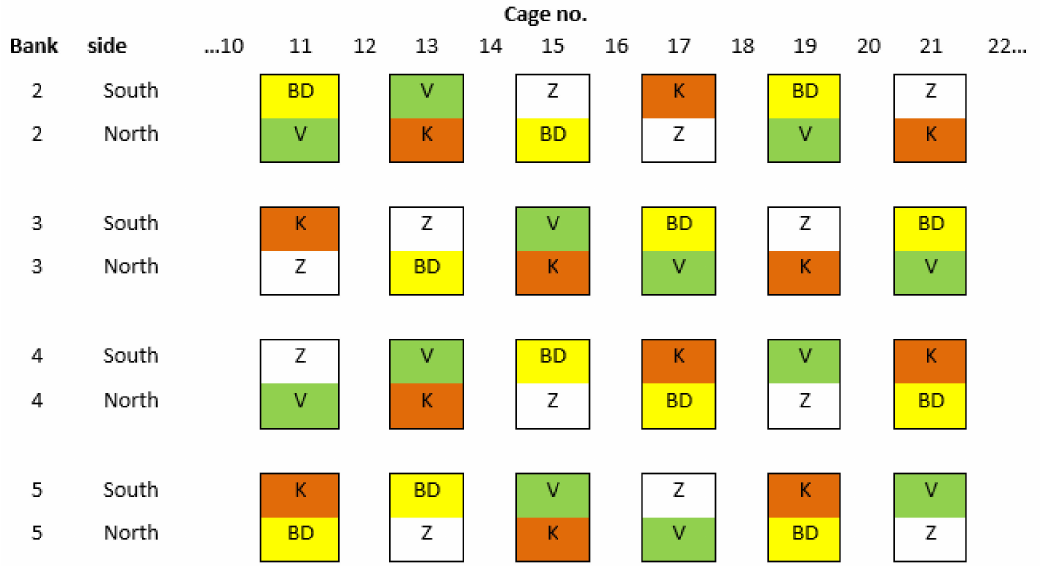
Figure 2. Overhead diagram of scratch mat treatment layout per cage in tier 5, at banks 2, 3, 4 and 5. BD = Big Dutchman, K = Kovobel, V = Valli, Z = Zucami design mats. There was one scratch mat on each side of the cage (north and south). Cage no. = cage